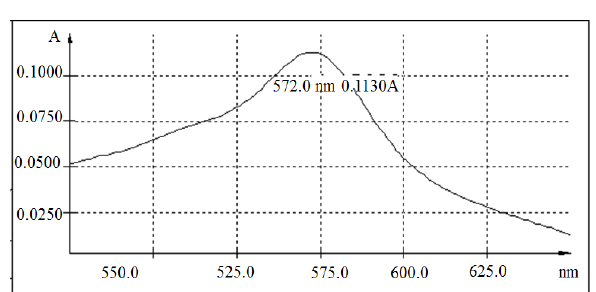
Fig. 7. Absorption spectrum of glucose solution P with α-naphthol in acidic medium with urea additives (6 mg/ml and boric acid 12 mg/ml)